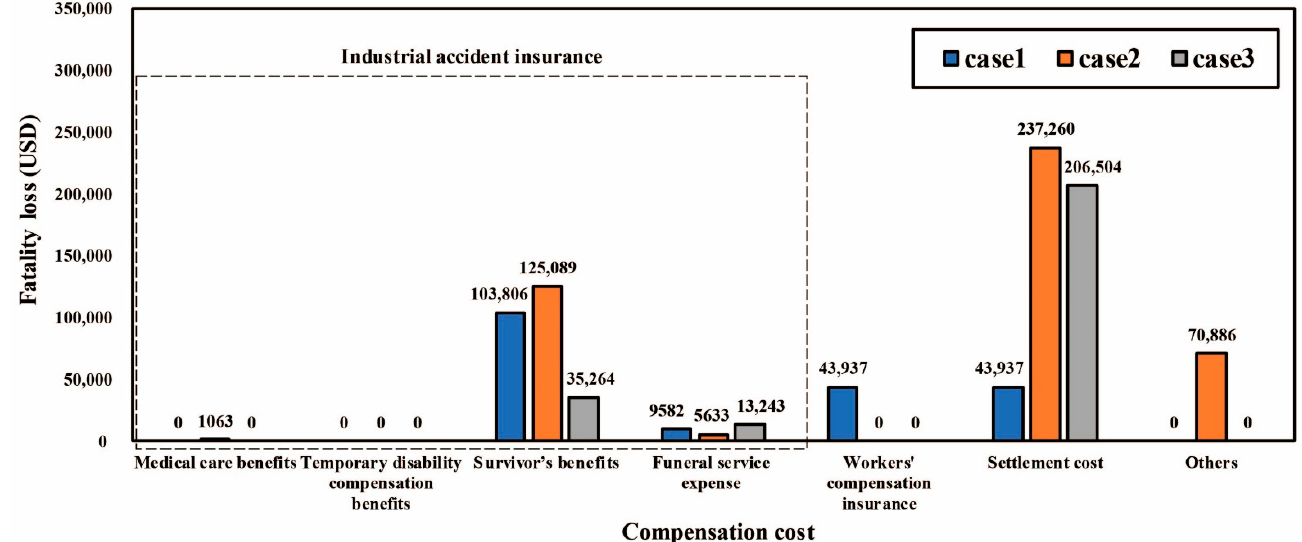
Figure 5. Comparison of compensation cost.